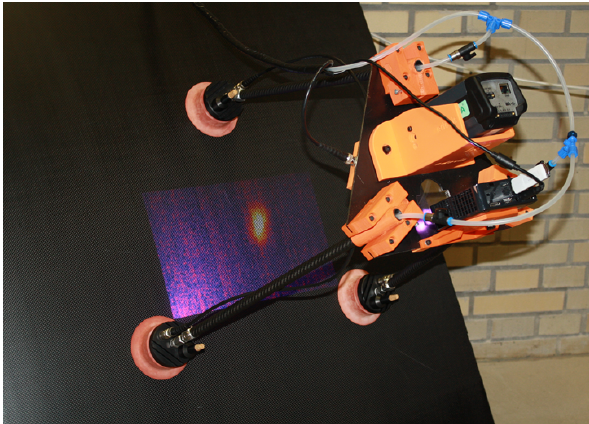
Figure 9. Mobile RFST system prototype in